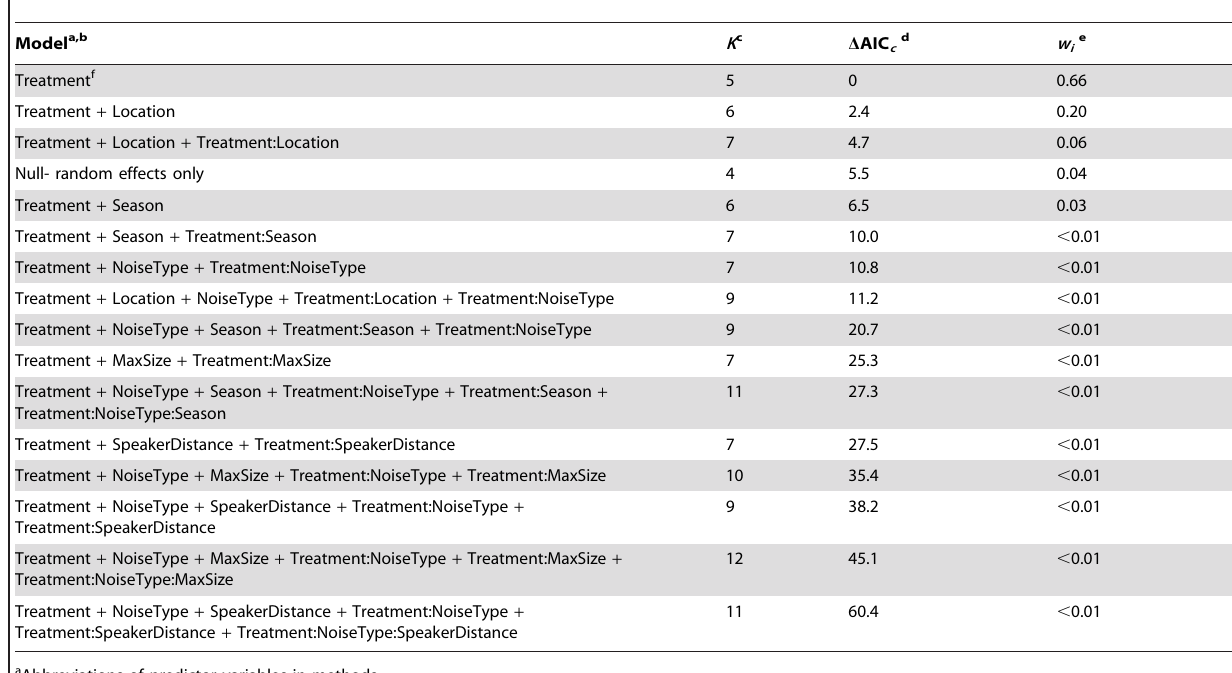
Table 1. Mixed-effect candidate models for the effect of noise playback on mass-dependent FCM concentrations (natural log-